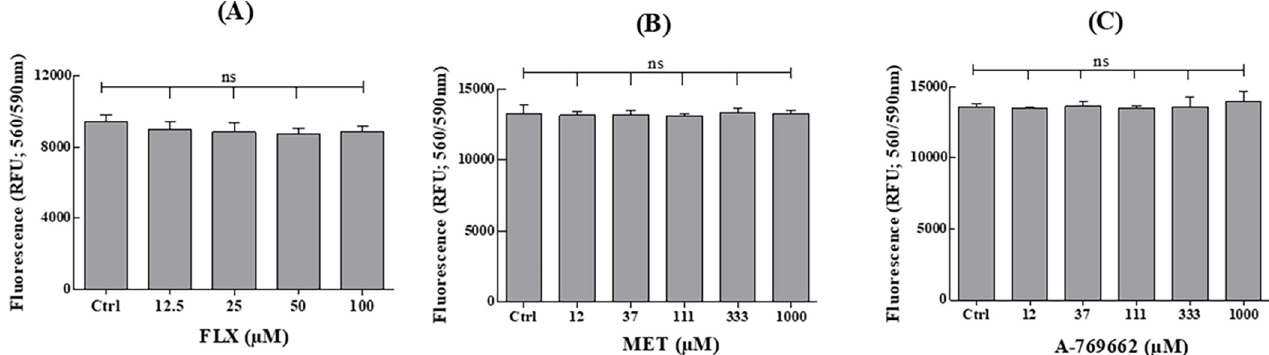
Fig 8. Effect of FLX, MET, or A-769662 on MLTC-1 cells viability. Cells were incubated at 37˚C for 1 hour in the presence or absence of FLX (A) or MET (B) or A-769662 (C). The experiments were repeated 6 times, values (%) are mean ± SEM (n = 6). Results were analyzed by one-way ANOVA, followed by the Dunnett’s test posttest). ns = no significant difference.